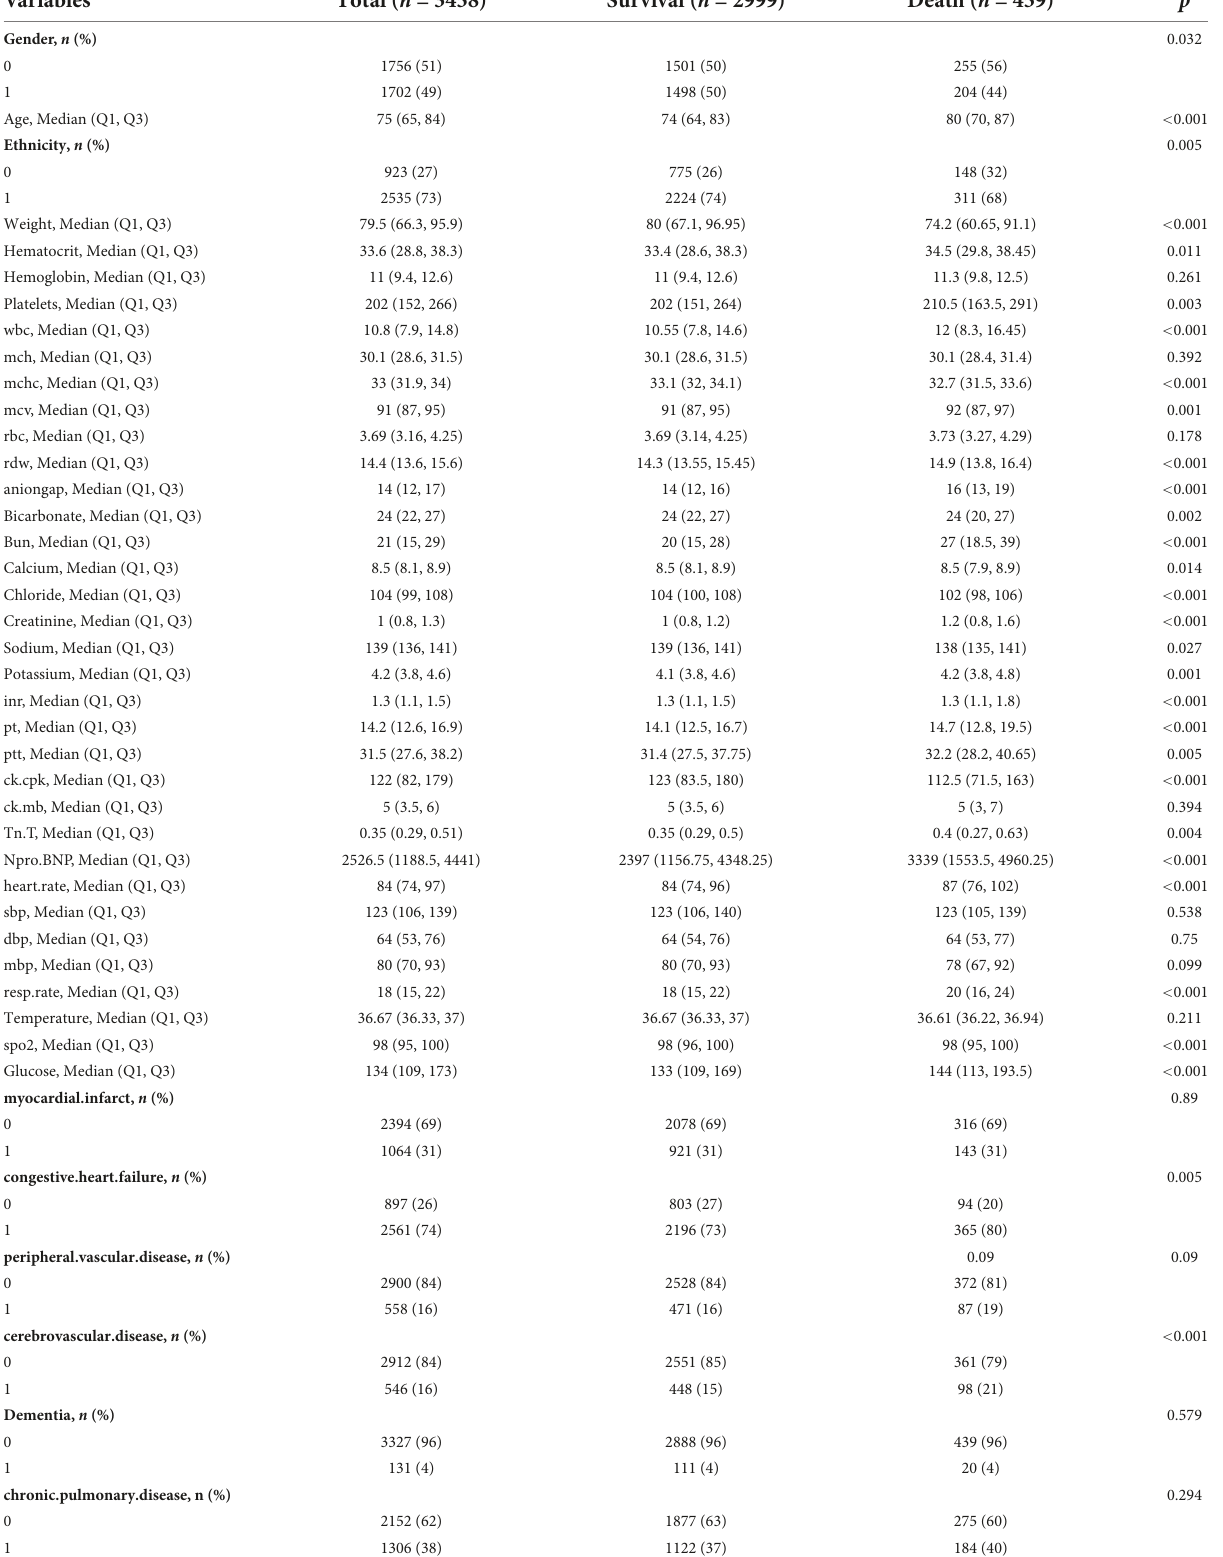
TABLE 1 Baseline characteristics, vital signs, laboratory parameters and statistic results of mimic-IIV patients with HF combined with